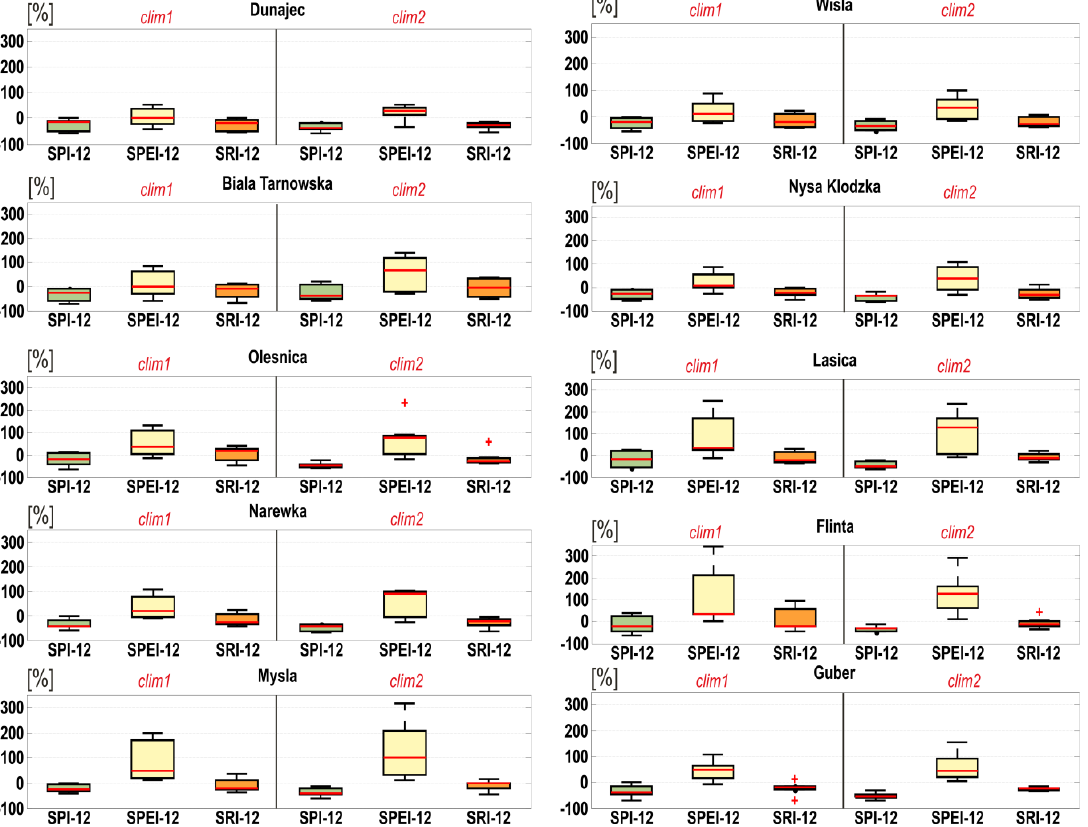
Figure 8. A comparison of the relative changes in the drought severity (%) between two future periods and a reference period. In each box, the central red mark denotes a median from seven climate model simulations, the edges of the box are the 25th and 75th percentiles, the whiskers extend to the most extreme data points not considered as outliers, and outliers are plotted individually in the form of red crosses.